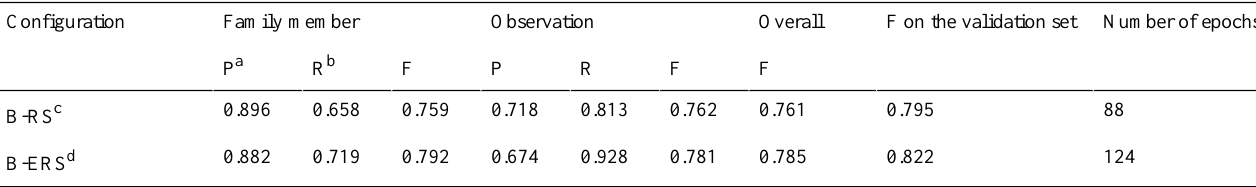
Table 3. Effect of the proposed enhanced relation-side scheme on the test and validation